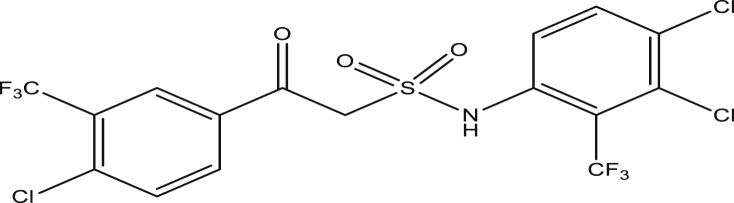
Compound 9f [2-(4-chloro-3-(trifluoromethyl)phenyl)-N-(3,4-dichloro-2-(trifluoromethyl)phenyl)-2-oxoethanesulfonamide (pEC500.6040010)].